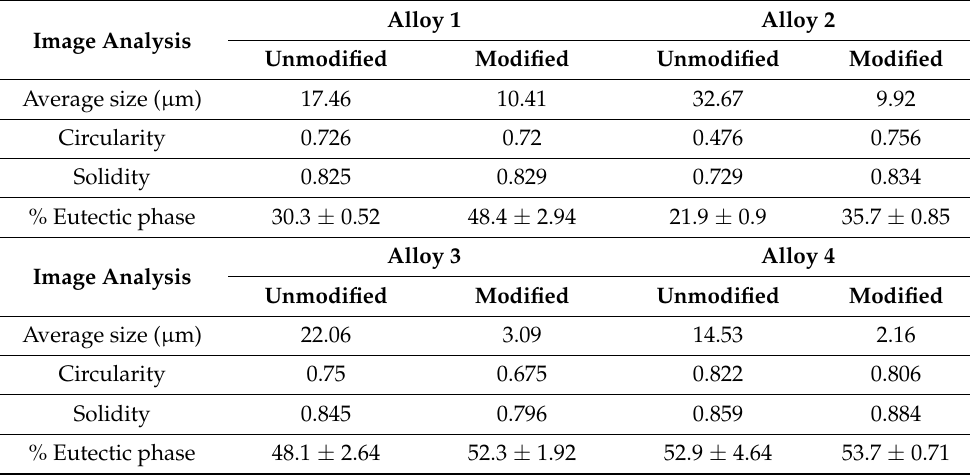
Table 4. Image analysis results for the characterization of the eutectic